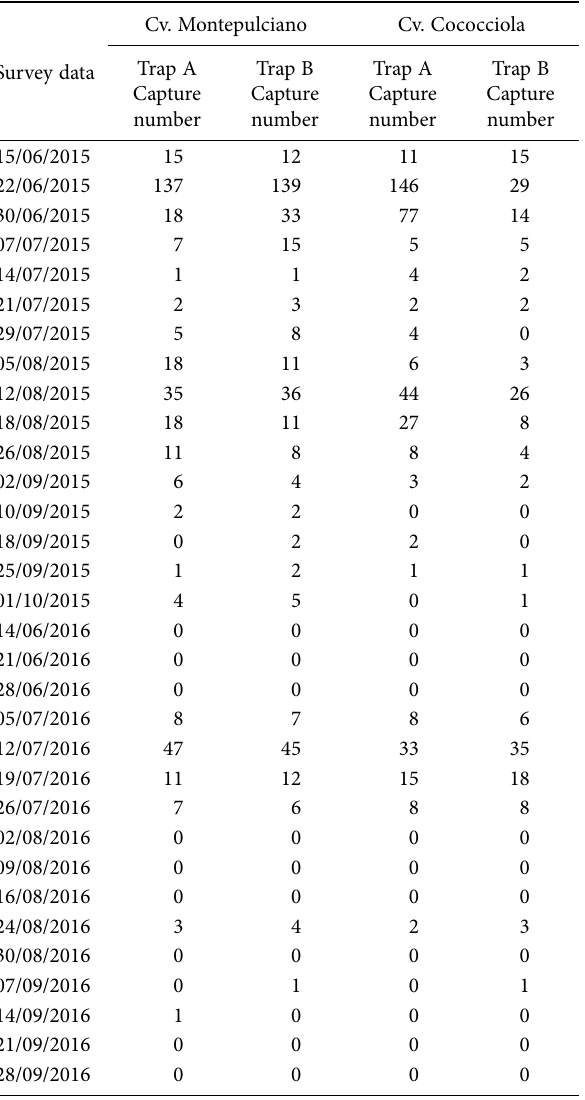
Table 4. Numbers of grapevine moth adults captured in traps in two grape cultivars in the Ari vineyard in 2015 and